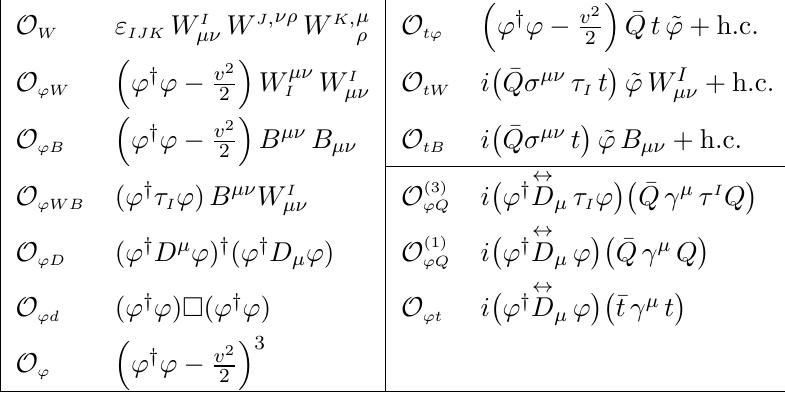
SMEFT operators at dimension-six relevant for the Higgs boson and the top quark in EW observables, in the so-called Warsaw basis [22], and where a U (3) 3 (cid:2) U (2) 2 (cid:13)avor symmetry is assumed. Q; t , and b denote the third generation components of q; u , and d